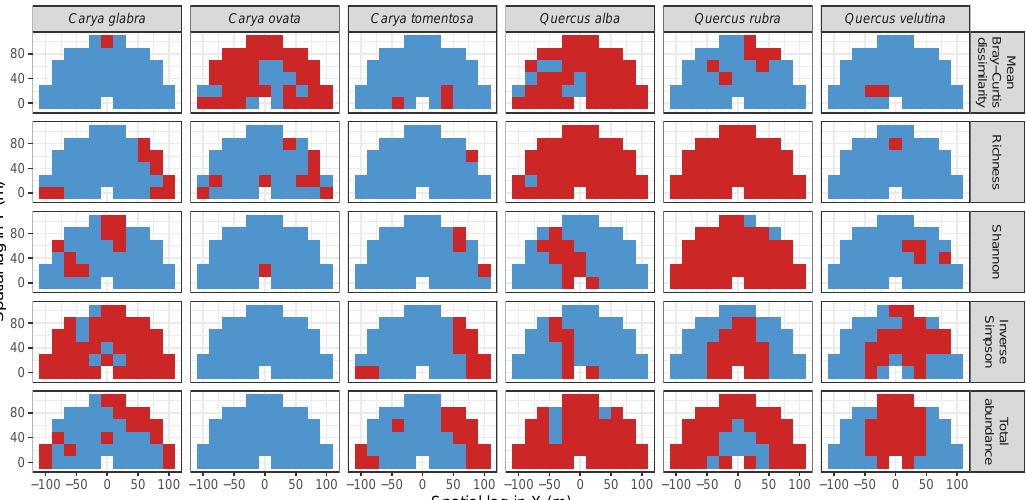
Figure 14. Statistical significance (red: P ≤ 0.05; blue: P > 0.05) of the codispersion coefficients calculated between measures of diversity and total basal area of the six focal tree species in 20 20-m subplots in the 20-ha Tyson Research Center plot (Figure 13). Statistical significance was determined by comparing observed codispersion at each spatial lag with a distribution of 199 spatial randomizations of a toroidal-shift null model. See Figure A2 for significance testing using a CSR null model.